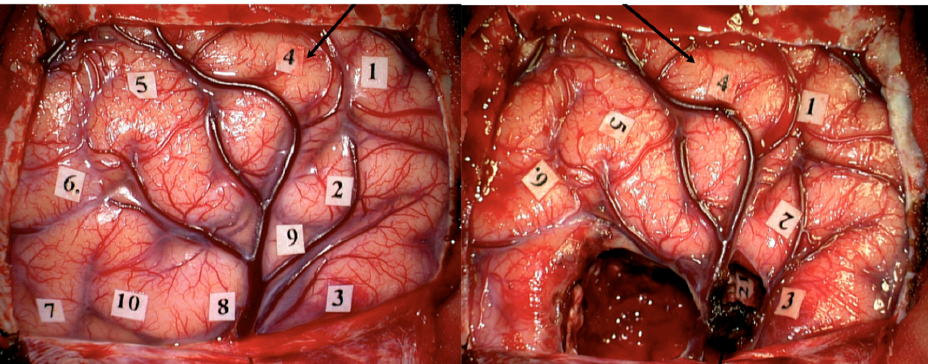
Figure 8. Language mapping during awake surgery in a patient with GBM. The black arrow shows the area related to speech arrest (1.5 mA), before ( left ) and after ( right ) tumor resection. Another clinical report with 309 consecutive patients who underwent AS for brain tumors located near eloquent cortex (language, motor, and sensory) concluded that neg- ative mapping of eloquent areas provided a safe margin for tumor resection and was